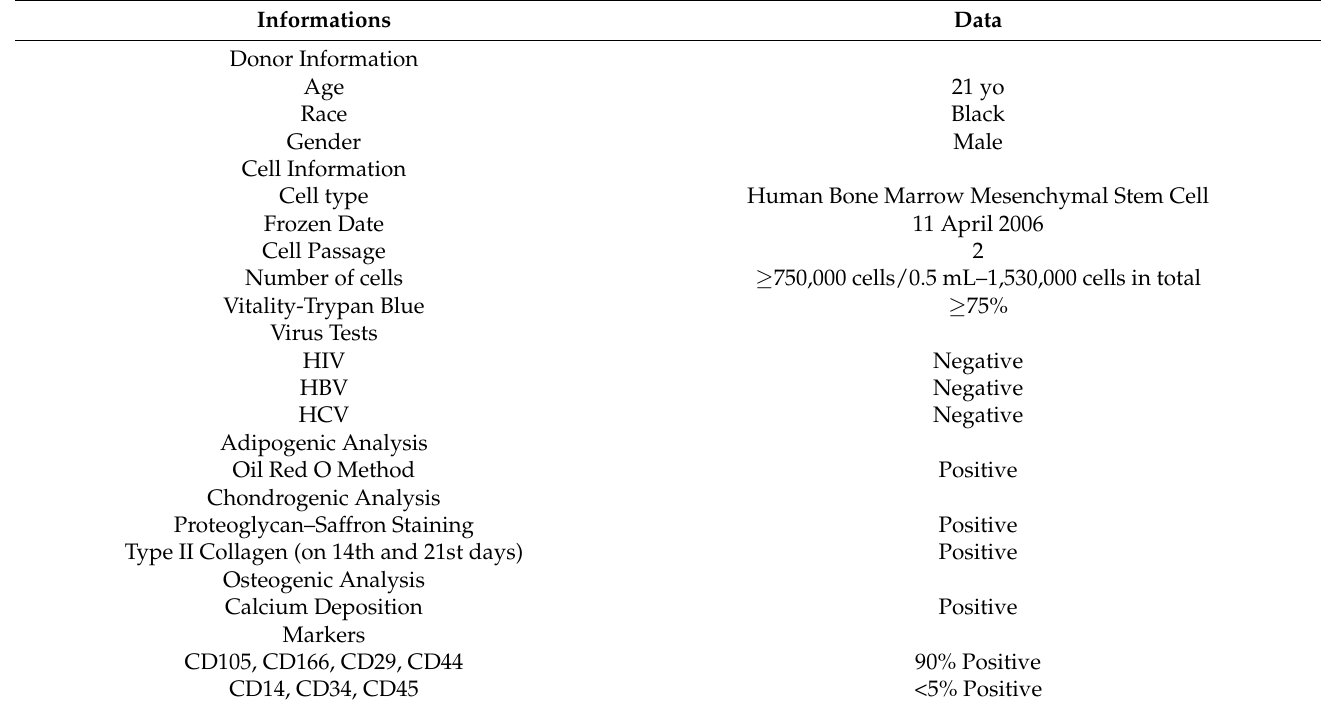
Table A1. Basic information about hBMSCs from the Cambrex